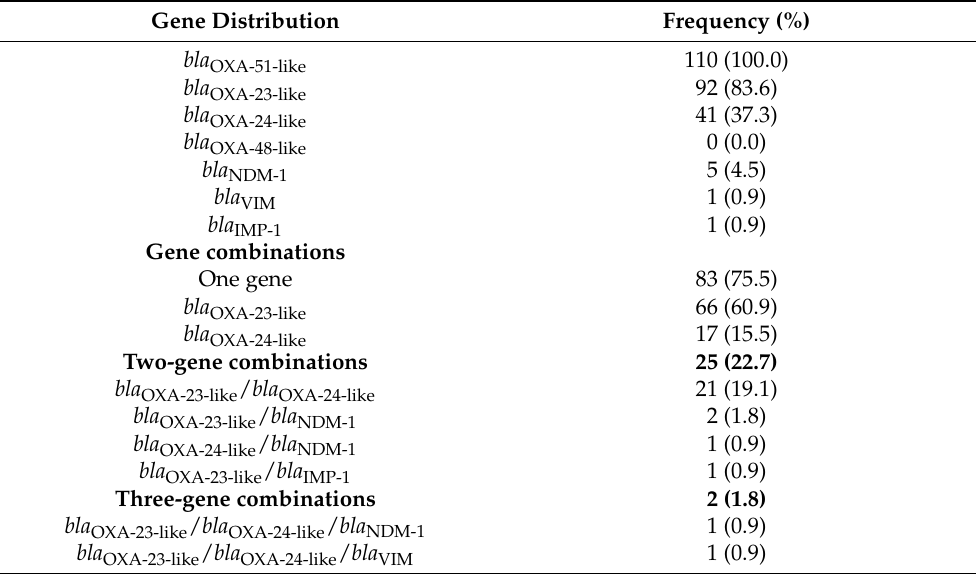
Table 2. Distribution of the carbapenemase genes in CNSAB isolates from bacteremia patients in Indonesia ( n = 110).